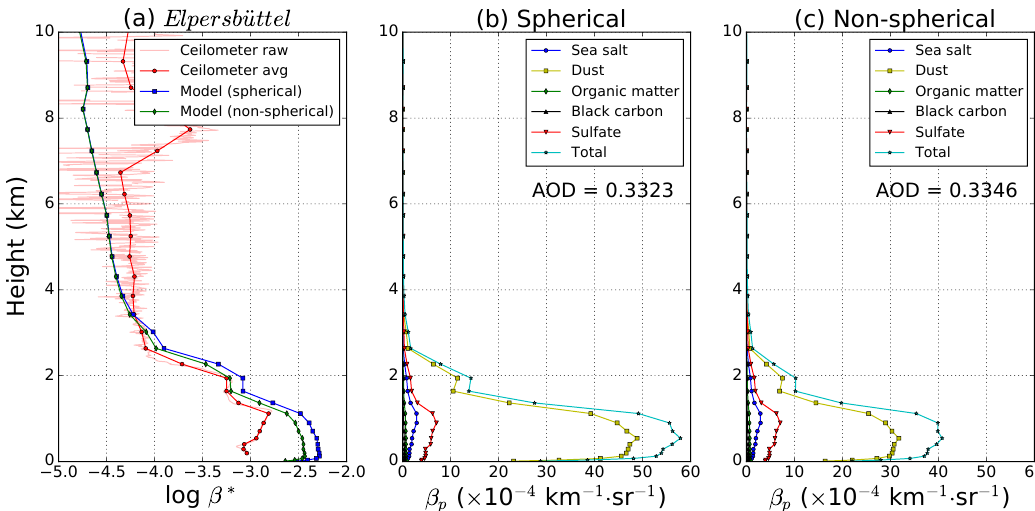
Figure 8. (a) Attenuated backscatter derived from the IFS model and the ceilometer data, respectively, during a dust episode at 18:00UTC on 3 April 2016 in Elpersbüttel. Model data are converted to β ∗ assuming either spherical (blue curve) and nonspherical (green curve) dust particles. Model results of the particle backscatter coefficient β p (light green) together with the contributions of each aerosol type assuming either spherical (b) or nonspherical (c) particle shape. The aerosol optical depth at 1064nm is virtually the same (AOD ≈ 0 .